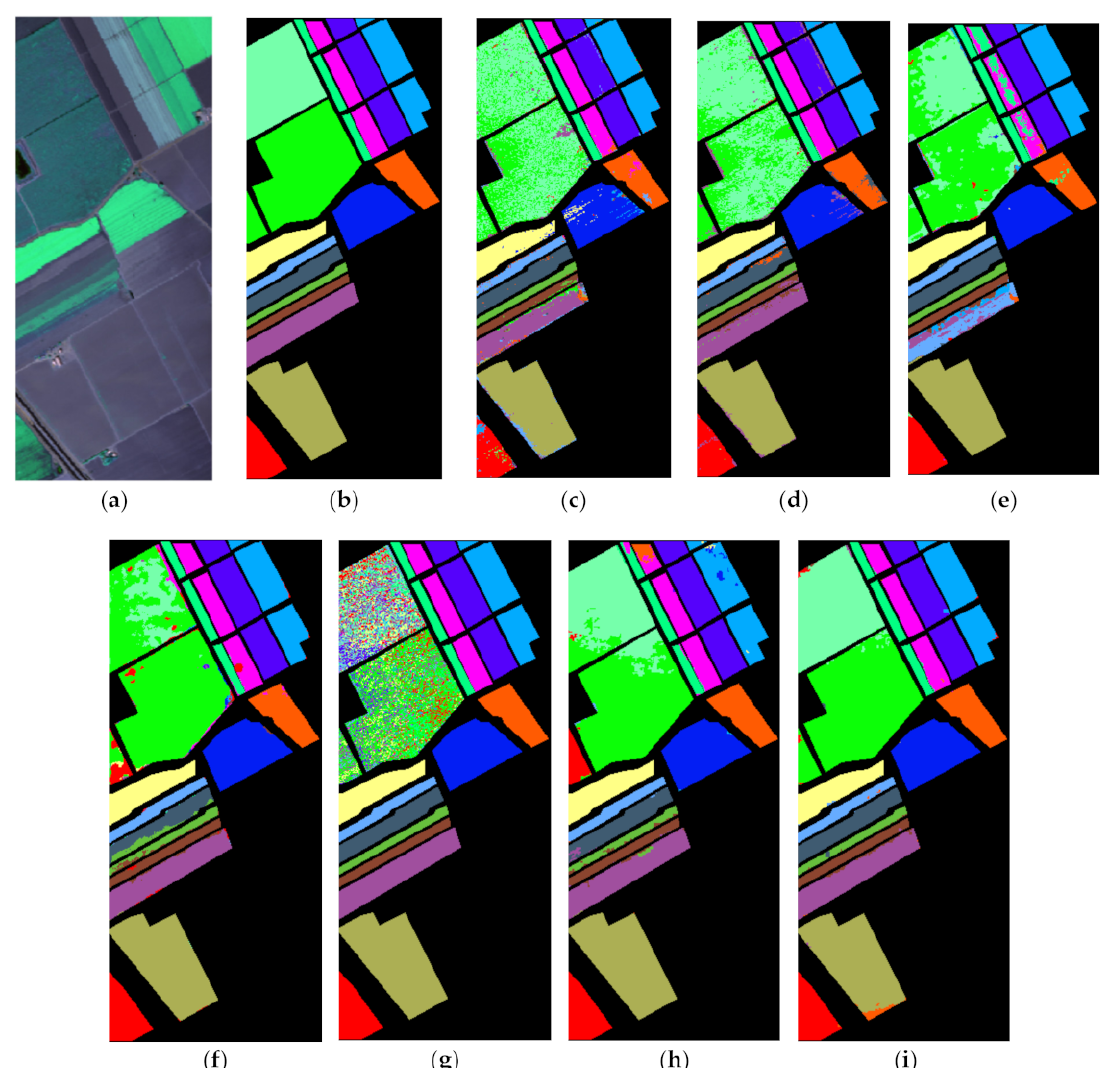
Figure 14. Classification maps obtained by different methods on the Salinas Dataset. ( a ) False- color image; ( b ) ground-truth map; ( c ) KNN; ( d ) SVM; ( e ) 2D-CNN; ( f ) 3D-CNN; ( g ) MiniGCN; ( h ) MDGCN; ( i )